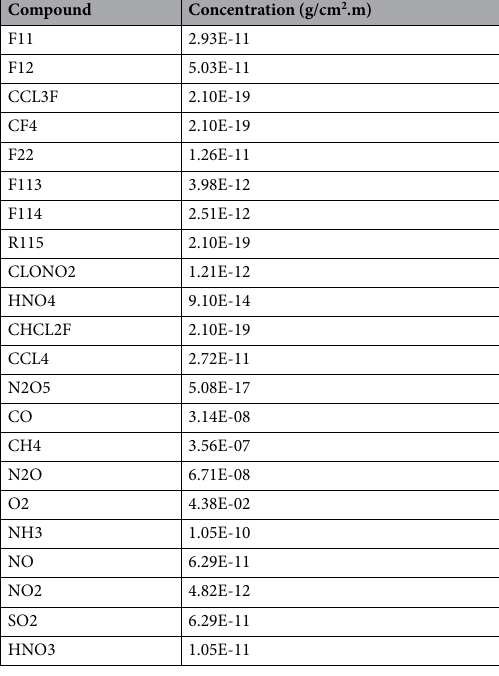
Table 1. Concentration of trace gases used for atmospheric correction.